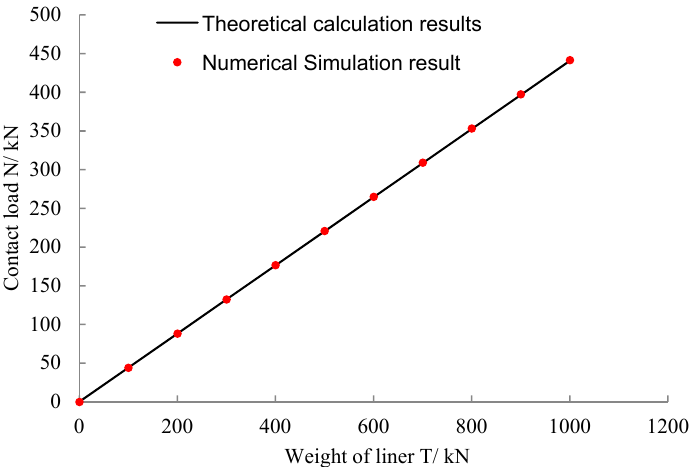
Figure 8. Comparison of results from theoretical calculation and numerical simulation.